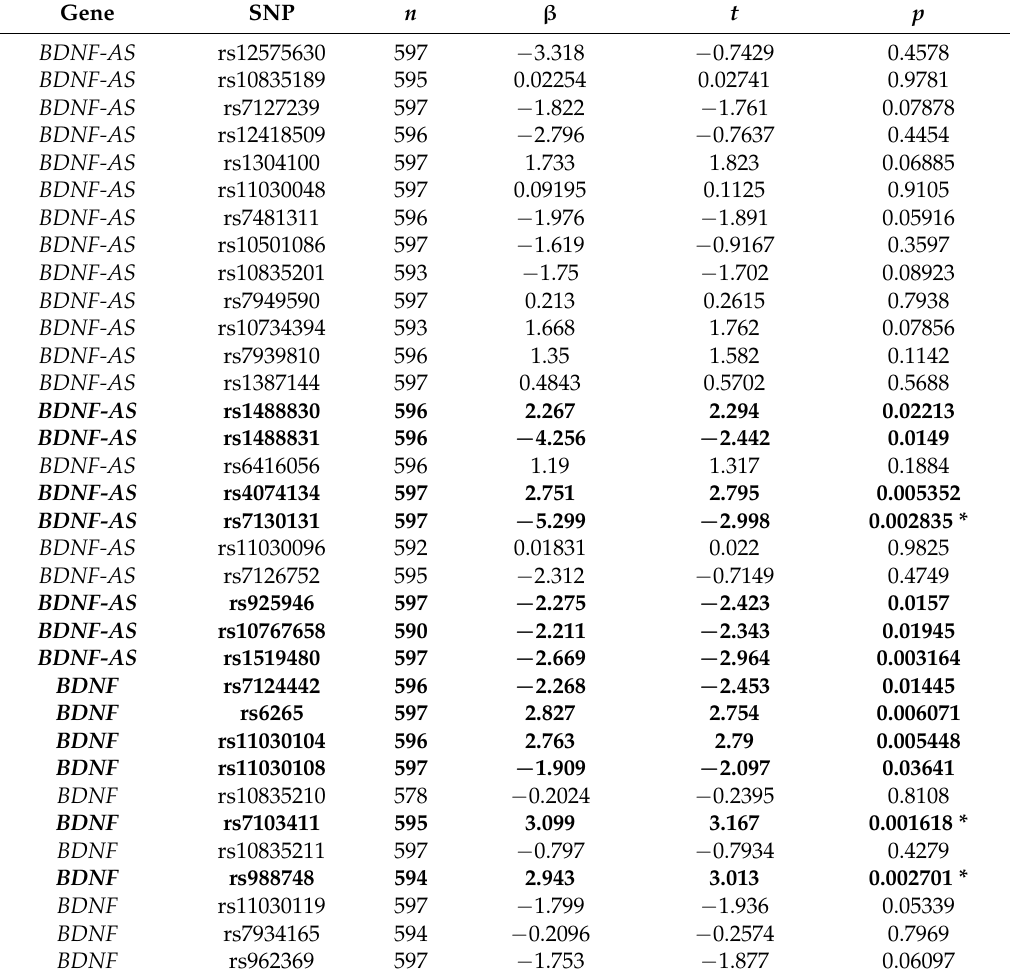
Table 3. Long-term visual memory score (VR II) association with BDNF and BDNF-AS